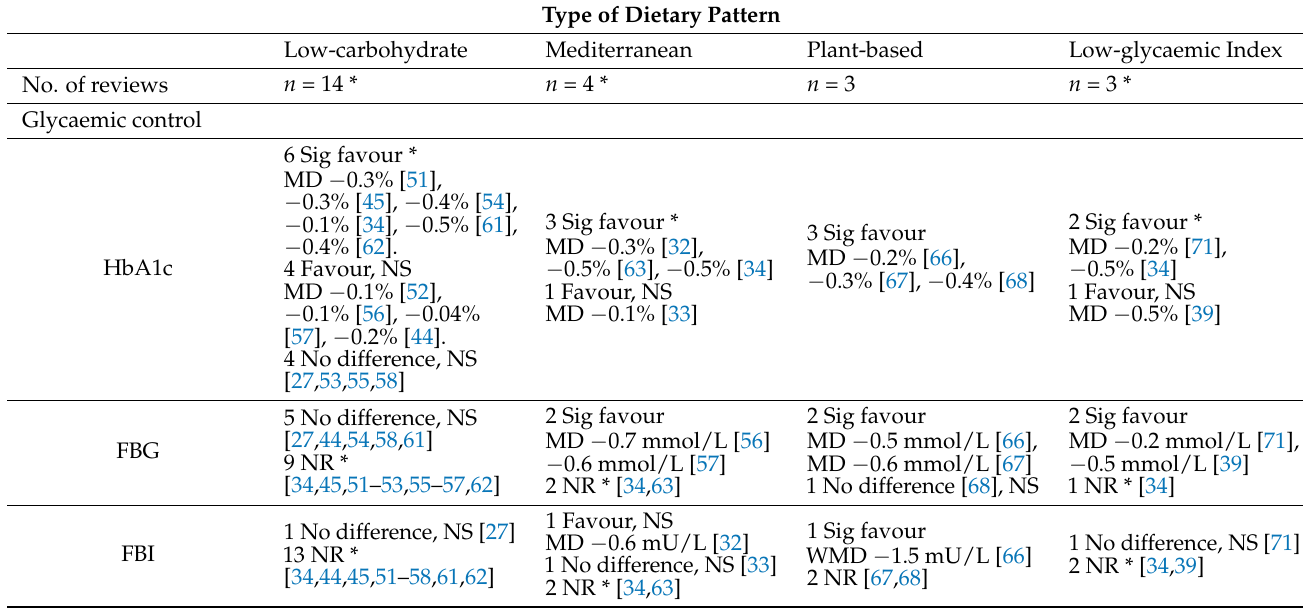
Table 4. Primary outcomes from systematic reviews with meta-analysis. Type of Dietary